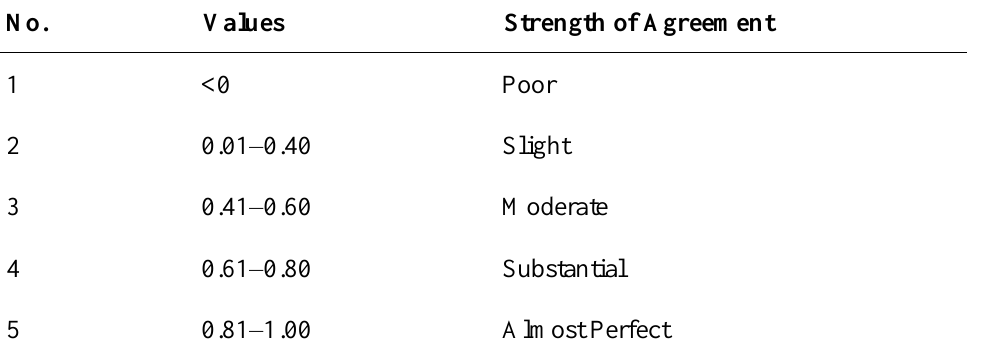
Table 3. Possible map comparative ranges and kappa value levels of agreement.